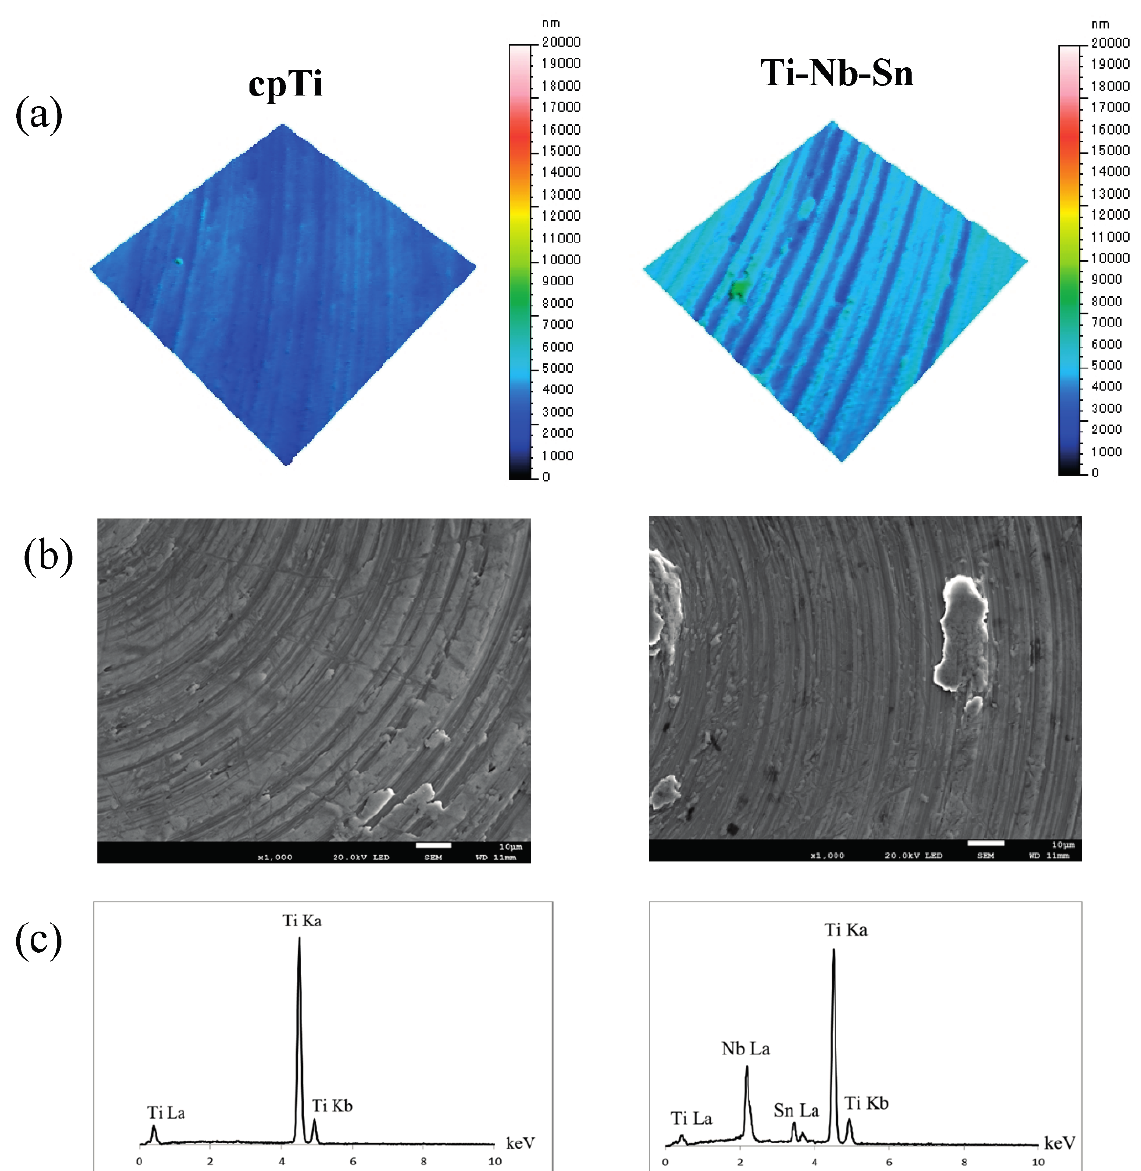
Figure 1. Surface characteristics of the specimens. ( a ) 3-D digital images; ( b ) SEM micrographs; and ( c ) EDX